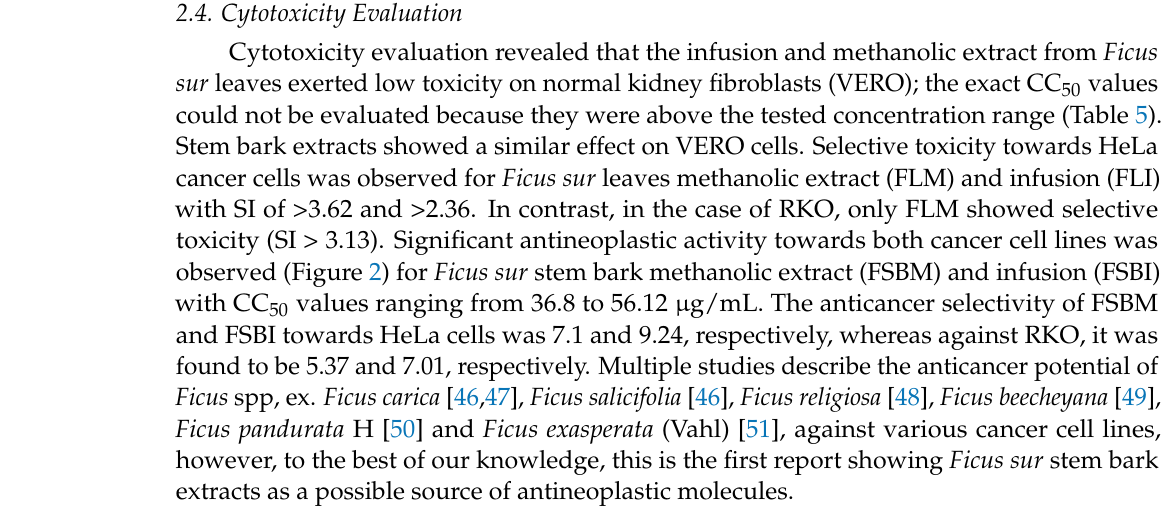
Table 5. Results of cytotoxicity